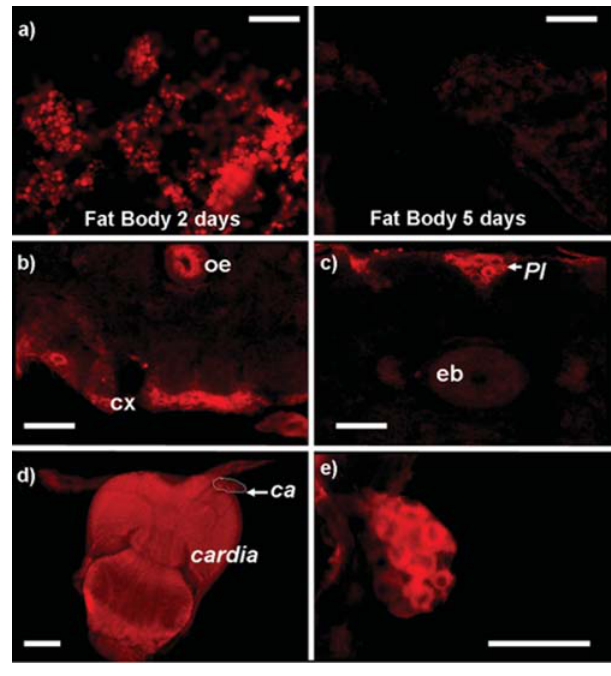
Figure 2. hmgcris expressed in the brain, the larval fat body, the cardiaand the corpusallatum. Immunohistological staining showing the HMGCR expression in various tissues, in adult fly. a, b, c) The HMGCR is expressed in the fat body in flies younger than 4 days (a, left). In flies older than 5 days, no HMGCR expression is detectable (a, right). The HMGCR is also expressed in some neurons, principally in the cortex of the brain (cx) (b) and some cells of the pars intercerebralis ( PI ) (c). oe: eosophagus, eb: ellipsoid-body. d, e) In the body, the reductase is detected in the cardia (d) and in the corpus allatum ( ca ) (e). For a negative control of the HMGCR staining, see Figure 5b, in comparison with figures 5a, c, d, e and g. Scale bar=25 m m.